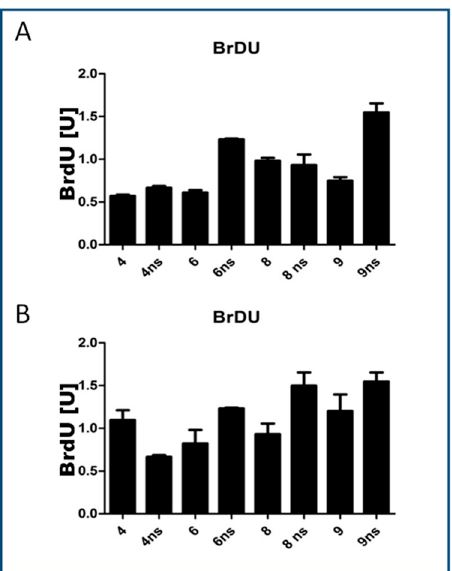
Figure 9. The results of the BrdU assay showing the differences in cell proliferation between experimental groups during the whole experiment (( A ) chondrogenic culture; ( B ) osteogenic culture, ns—non-stimulated control, materials described in Table